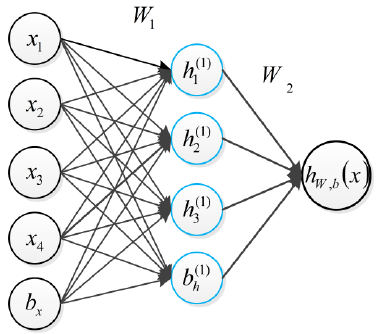
Figure 2. A simple example of an autoencode.